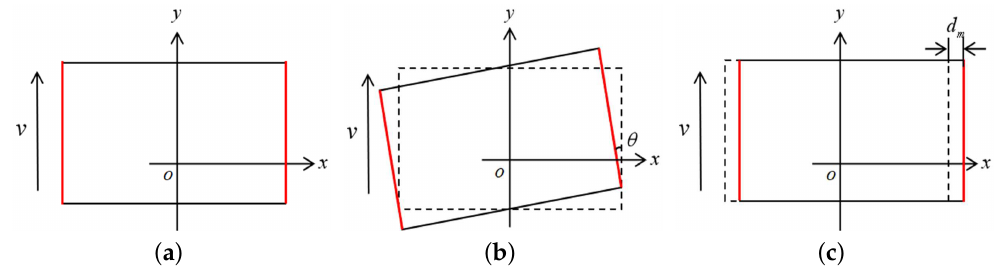
Figure 2. Schematic diagram of deviation: ( a ) normal condition, ( b ) deflection condition, ( c ) overall offset condition, v represents the speed direction of the conveyor belt, and θ represents the deflection angle of the conveyor belt, d m represents the lateral displacement of the conveyor belt along the bandwidth direction.